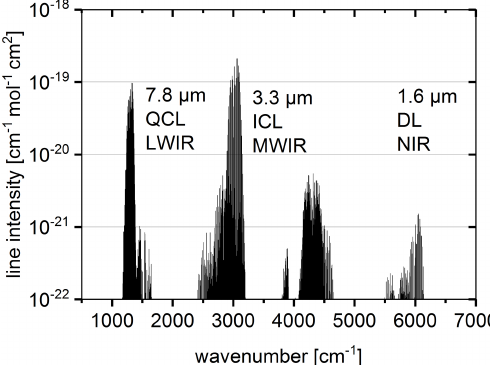
Figure 1. Methane IR absorption bands in the long-wave infrared (LWIR), mid-wave infrared (MWIR) and near-infrared (NIR) spec- tral regions versus wavenumber (i.e. inverse wavelength in cm − 1 ). Line data are obtained from the HITRAN database (Rothman and Gordon, 2013). The applied types of semiconductor lasers (DL for NIR, ICL for MWIR, and QCL for LWIR) are also